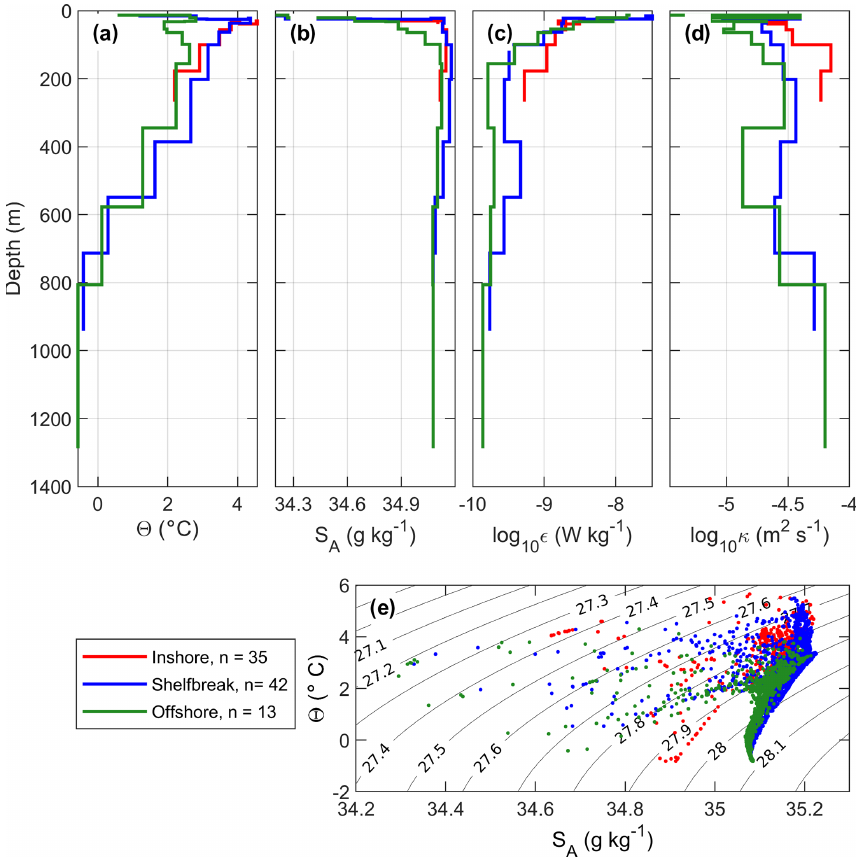
Figure 4. Isopycnally averaged profiles of (a) (cid:50) , (b) S A , (c) dissipation rate (cid:15) and (d) diapycnal diffusivity κ . The profiles are shown using the average depth of the isopycnals. (e) θ – S A diagram. Profiles are selected relative to the distance from the 800m isobath: − 10km (red) inshore, at the shelf break in the Atlantic Water core (blue), and 10km offshore (green). In the legend, n indicates the number of batch-averaged profiles used in each